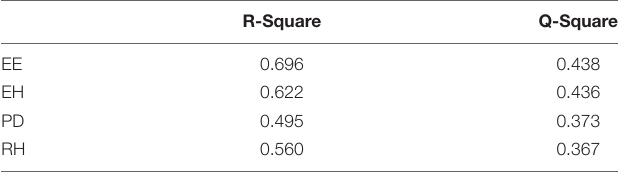
TABLE 6 | R -squared values and Q -squared values for the variables.